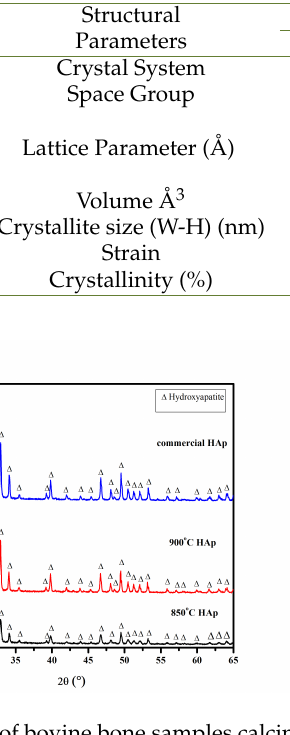
Fig. 2. X-RD pattern of bovine bone samples calcined at 850 o C, 900 o C, and commercial